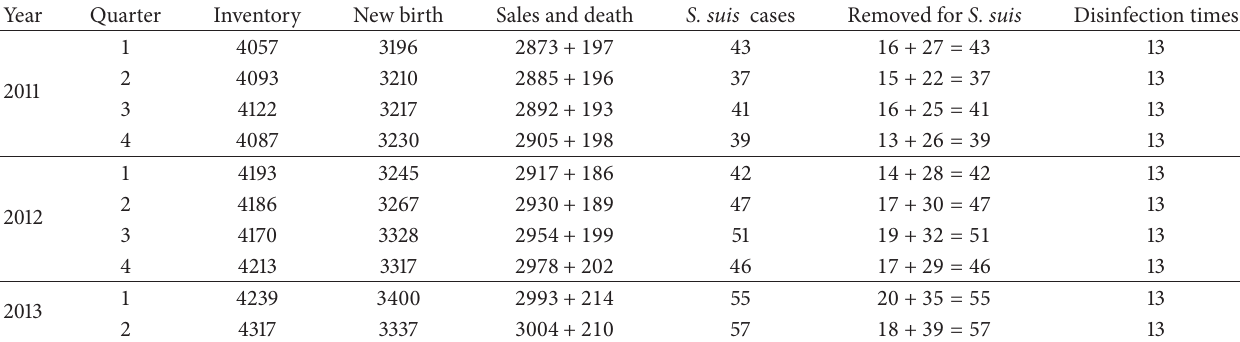
Table 1: Swine data and incidence of S. suis for the past three years from a swine farm in southern China.